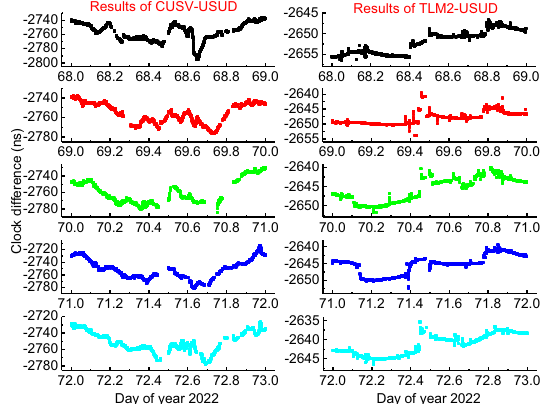
tion. The third is the STD values of the clock difference are about 1–2 ns for GPS PPP, which supports the previ- ous conclusion that GPS PPP using the PPP-B2b correc- BDS-3 PPP time transfer accuracy is about 0.2 ns for all time series using the PPP-B2b correction. In addition, the improvement of BDS3/GPS with respect to the BDS-3 PPP time transfer is very limited. There are three possi- ble reasons for the above phenomenon: (1) the qualities of the products recovered from the PPP-B2b correction were much worse than that of BDS-3 satellites; (2) very fewer GPS satellites were used. Fig. 6 shows the number of satellites used on DOY 68, 2022; (3) The User Range Error (URE) in the PPP-B2b service was added to the weight of each satellite. In addition, we can see that there are some epochs when the number of used GPS satel- lites is small in the PPP processing. Unlike final precise products, the PPP-B2b service does not provide the orbit and clock corrections for all GPS satellites at any given moment. Moreover, some GPS satellites were excluded due to their large residuals. After the filter update, we check the observation residuals for each satellite. If the residual of a satellite exceeds some torelance, the weight of this abnormal observation is reduced, and the filter restarts. If the result is still not satisfied, we will further eliminate the satellites with too large residuals. To further analyze PPP time transfer using the PPP- B2b service from the frequency domain, we calculated the Modified Allan Deviation (MDEV) of CUSV-USUD and TLM2-USUD time links and display them in Fig. 7, respectively. The mean MDEV of CUSV-USUD obtained from BDS-3, GPS, and BDS-3/GPS PPP is about 2.56 10 –12 , 2.24 10 –12 , and 2.23 10 –12 at × × × 960 s. In addition, the mean MDEV of TLM2-USUD is about 1.86 10 –13 , 3.12 10 –14 , and 3.05 10 –14 at 960 s. × × × In terms of short-term frequency stability, GPS PPP is much worse than BPS-3 PPP, especially for the TLM2- USUD, and the improvement by including GPS satellites to BDS-3 PPP is limited with the PPP-B2b correction, which is similar to the above conclusion. Besides, the long-term frequency stability also shows a similar char- acteristic with (8.53 10 –13 , 7.68 10 –13 , 7.61 10 –13 ) × × ×